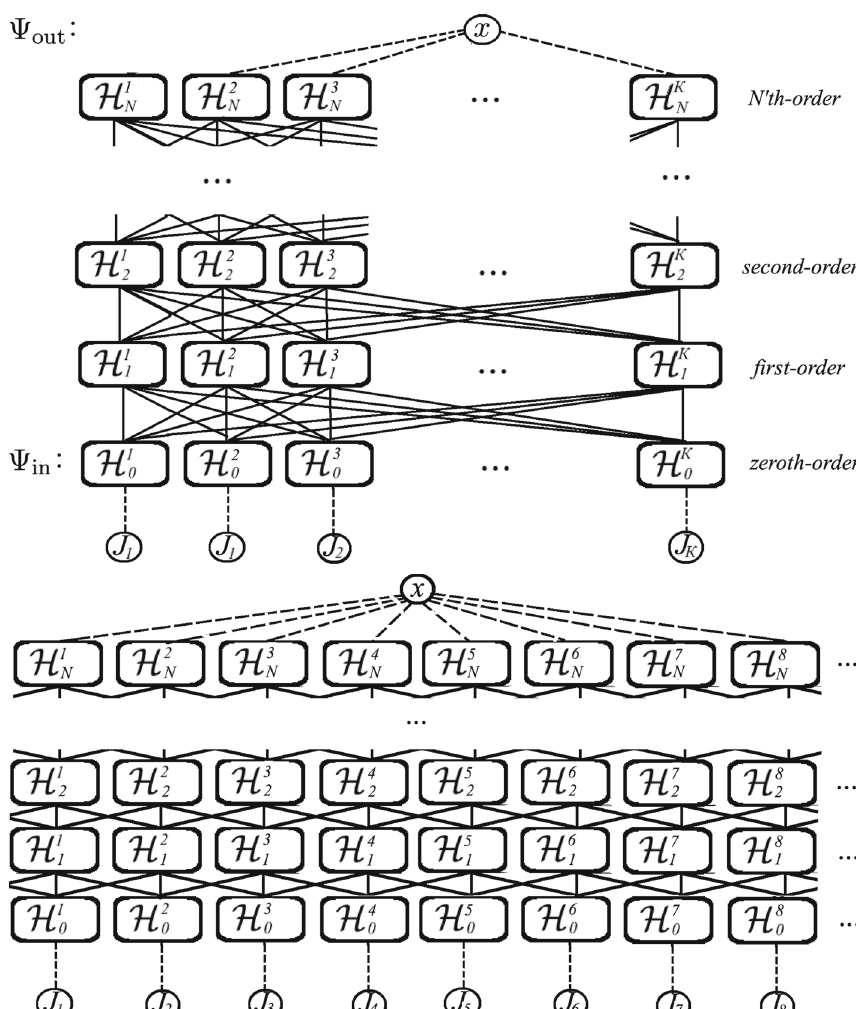
Fig. 1 Interactions network of